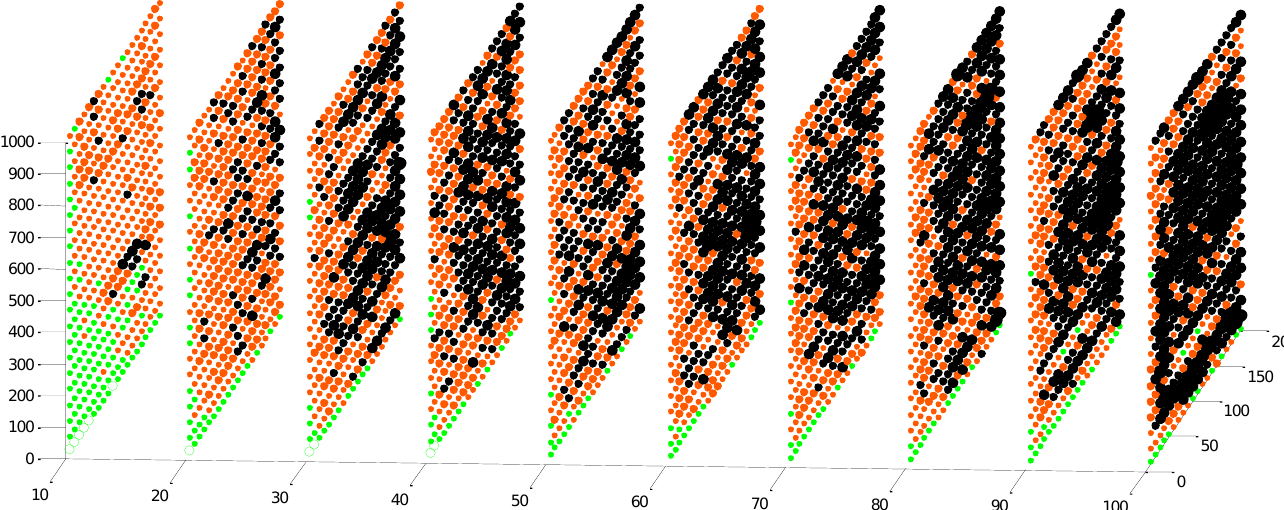
c on CIFAR-10 images. This is the best one. Overall accuracy is acceptable, although a few unacceptable (circled) points exist by Fig. 5. Performance 32